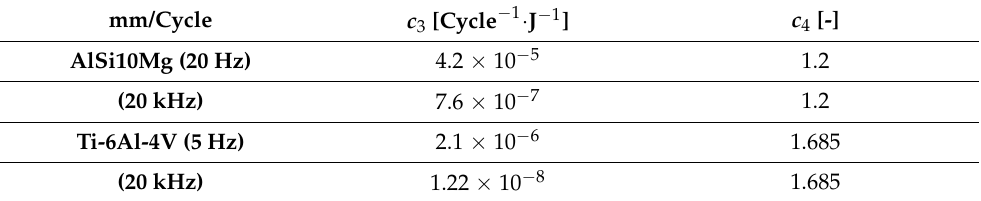
Table 2. Energy release rate crack propagation parameters according to Equation (11).